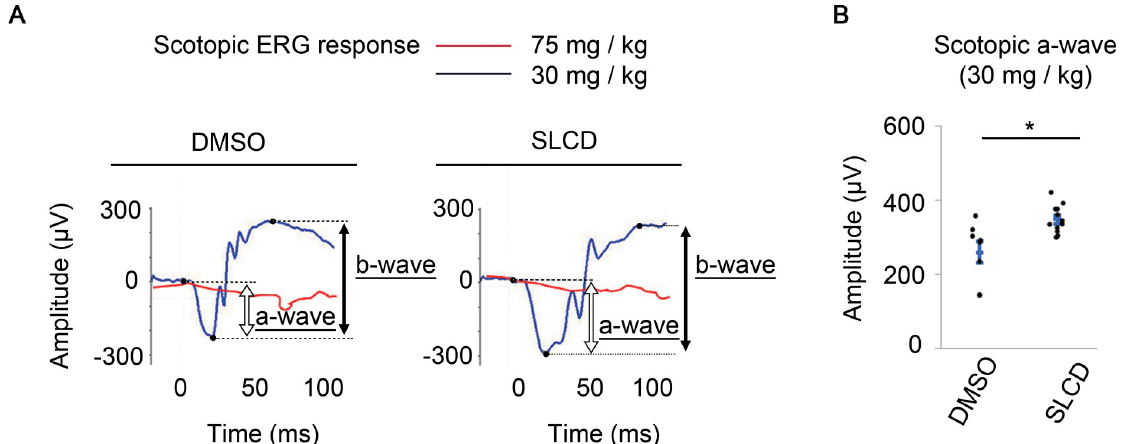
Fig 4. Improvement of the retinal function by MC-derived Rho-positive cells in MNU-treated mice. A) Scotopic responses of the ERGs on day 7 after the intravitreal injection of SLCD. ERG waveforms for the 75 mg/kg MNU group are shown in red, and those for the 30 mg/ kg MNU group are shown in blue. B) Effect of the compounds on the a-wave in the 30 mg/kg MNU group. All data are presented as the mean ± SEM (DMSO, n = 8; SLCD, n = 12). � p < 0.05, as per Wilcoxon rank sum test.